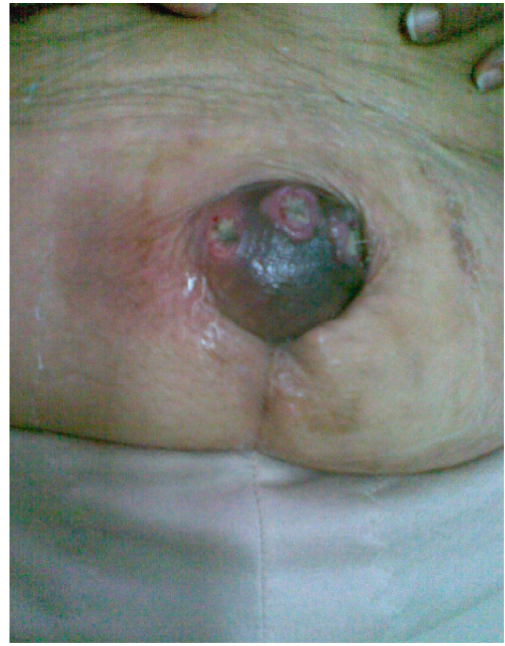
Figure 1: A 9-centimeter inflammatory and painful umbilical tumor with a hard consistency.